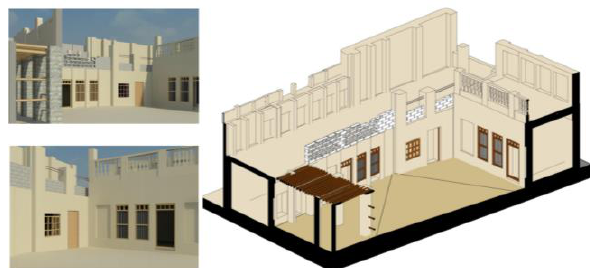
Figure 13 BIM model of the Aljazzaf house developed from the consolidated pointcloud and render samples generated from the BIM model. Software employed Autodesk Revit 2016. Images source Authors and Marwa Reyadh